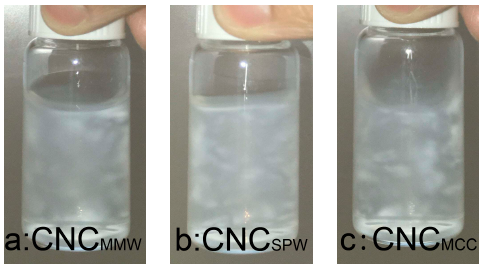
Figure 4. Flow birefringence of cellulose nanocrystal suspensions between two cross polarizers ( a ) CNC MMW , ( b ) CNC SPW , and ( c ) CNC MCC .